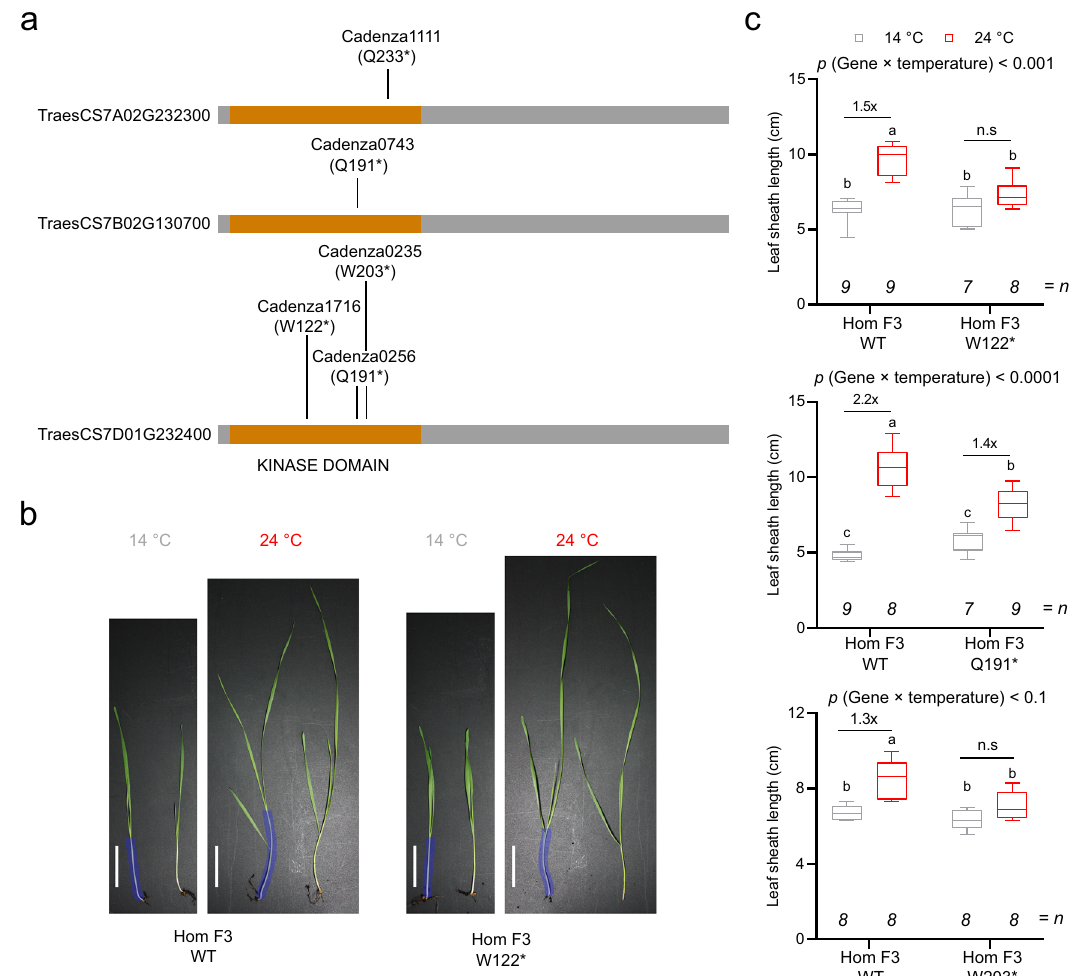
Fig. 3 TOT3 is required for thermomorphogenesis in wheat. a Position of stop codons (*) in wheat TILLING lines Cadenza1111 (Q233*), Cadenza0743 (Q191*), Cadenza1716 (W122*), Cadenza0256 (Q191*) and Cadenza0235 (W203*) in protein models for three wheat TOT3 homeologues. b , c Length of the visible leaf sheath (in those cases where the second leaf has not emerged, this leaf sheath is underneath the one of the fi rst leaf) in homozygous F3 wild-type (WT) and tot3 two-week old Cadenza wheat seedlings (all lines were backcrossed once with WT Cadenza and WT plants were selected from the backcrossing with each Cadenza TILLING line) grown at 14 and 24 °C in long-day conditions (16 h light/ 8 h dark). Representative pictures ( b ) and leaf sheath length quanti fi cation ( c ). Scale bar, 2 cm. Blue overlay in ( b ) marks the leaf sheath. Box plots show median with Tukey-based whiskers and outliers. The number of individually measured seedlings ( n ) is indicated above the X -axis. The respective quanti fi cation letters indicate signi fi cant differences based on two-way ANOVA and Tukey ’ s test ( p < 0.01); n.s: not signi fi cant ( c ). The p -value for the interaction (genotype × temperature) is shown at the